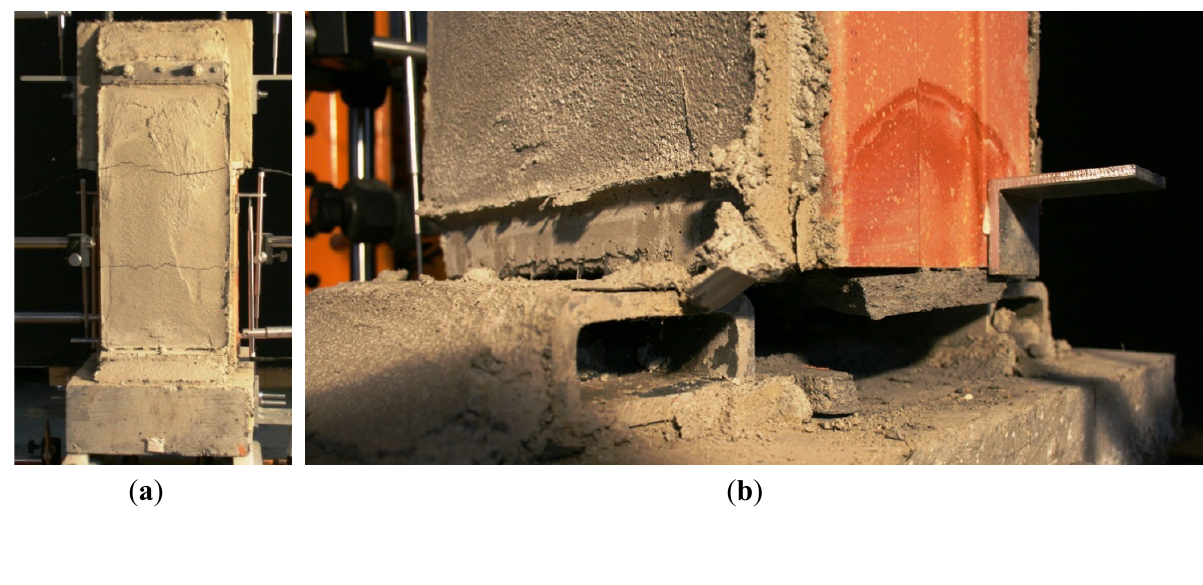
Figure 17. ( a ) Cracking in test AT-G5; and ( b ) Failure in test